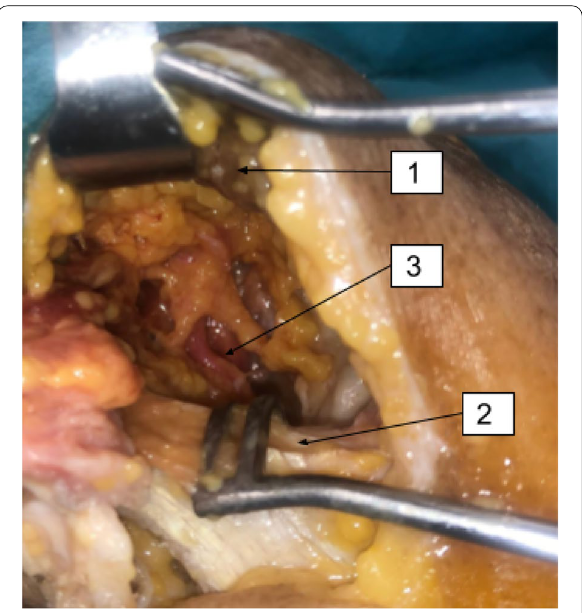
Fig. 4 Posterior approach. (1) Supra-spinatus muscle; (2) Spine of the scapula; (3) Surpa-scapular nerve at the supra-spinatus fossa